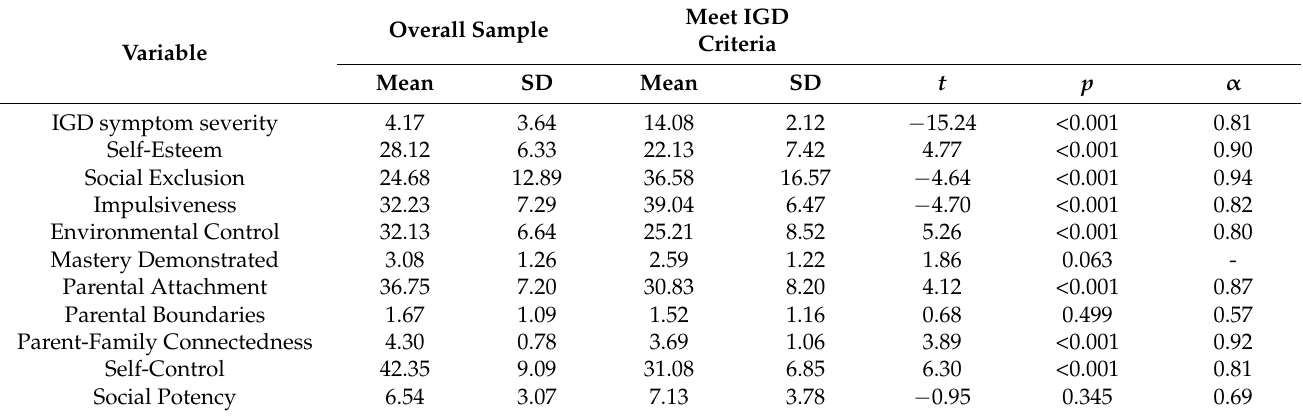
Table 1. Descriptives for overall sample and those who met IGD criteria; Scale